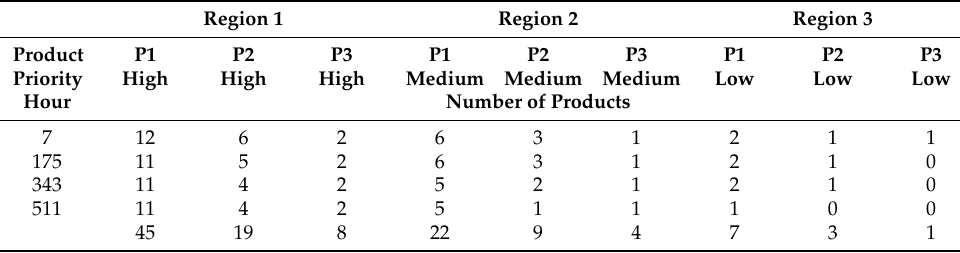
Table 9. Monthly order entry of the SC scenario with centralized